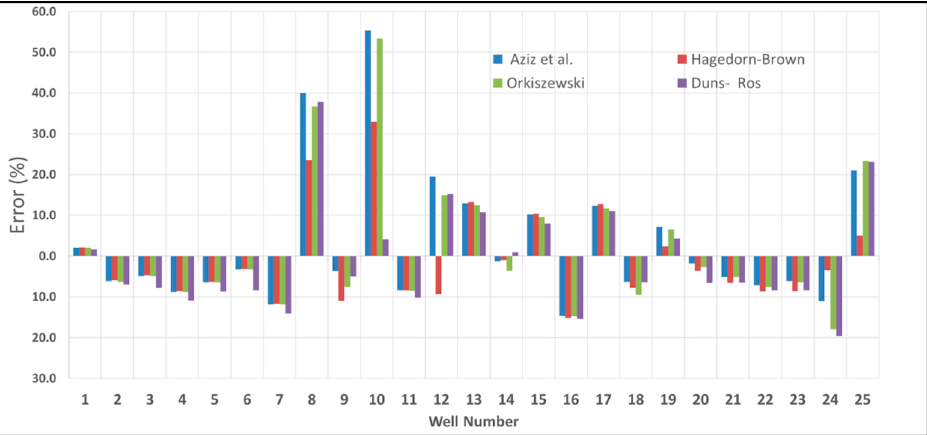
Figure 7. Hold-up prediction accuracy using some popular correlations. Table 3. Statistical results for the various prediction correlations.